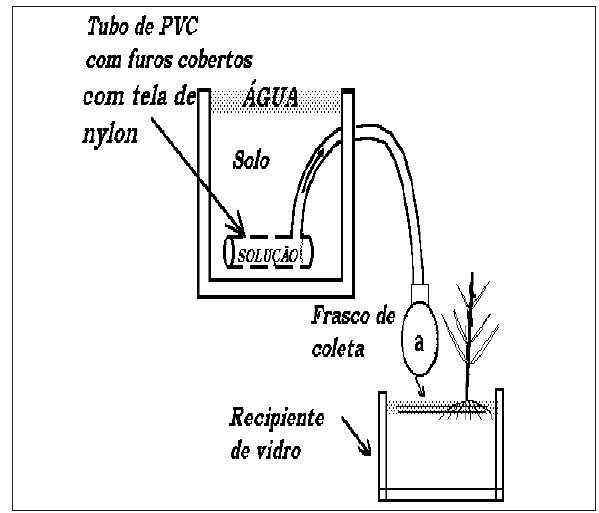
Figura 1. Representação do sistema utilizado no alagamento do solo e cultivo das plantas; (a) recipiente utilizado na extração e homogenei- zação das soluções dos solos